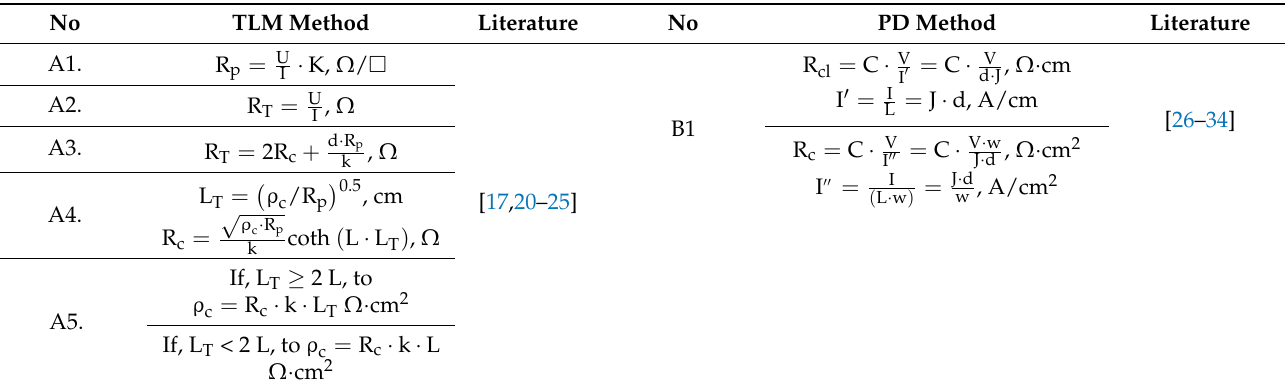
Table 1. Formulae and quantities characterising the metal–semiconductor junction according to the method applied.